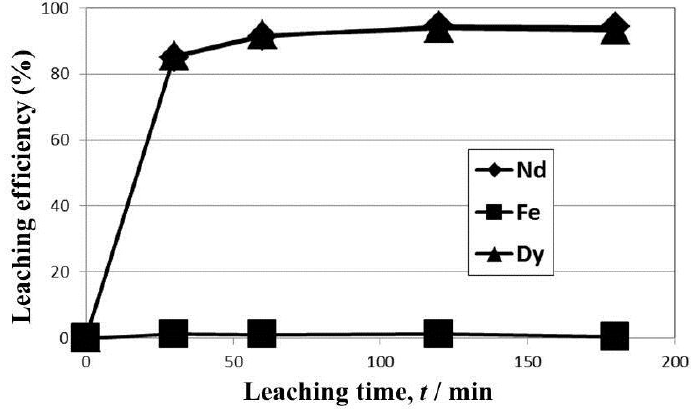
Figure 3. XRD patterns of roasted sample with temperature (Grinding conditions: 15 in stoichiometric molar ratio, 550 rpm in rotational speed, 5 cm 3 in water addition, 30 min in grinding time).